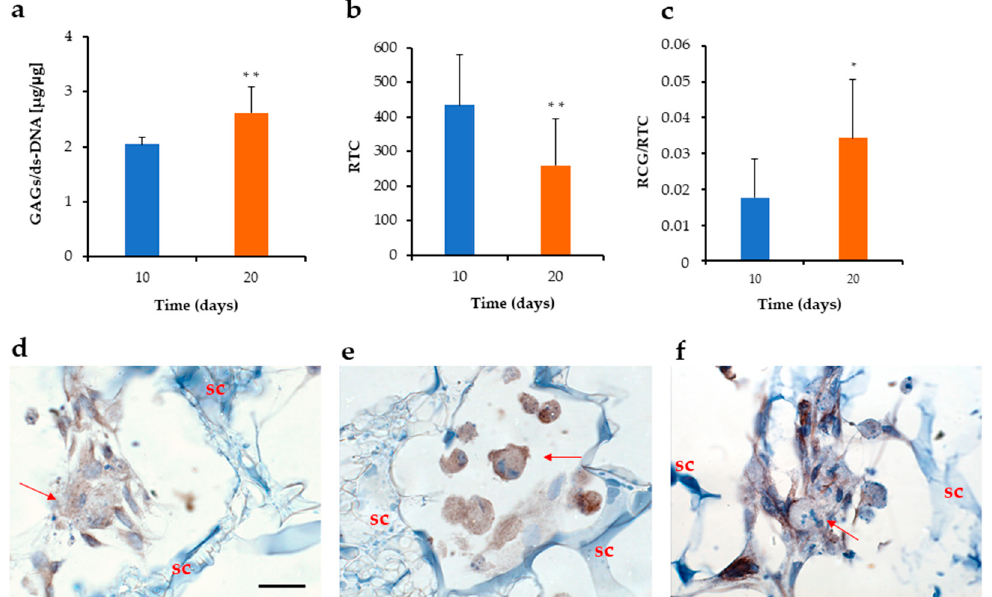
Figure 4. Bar graphs of the 3D cartilage model at 10 and 20 differentiation days: ( a ) GAG content normalized by ds-DNA content; ( b ) RTC number evaluated at 10 and 20 days; ( c ) RCG number normalized by RTC evaluated at 10 and 20 days. * p < 0.05; ** p < 0.01. RTC = Rounded Total Cells; RCG = Rounded Cell Groups. ( d – f ) Immunohistochemistry for Sox-9, Aggrecan and collagen type II in brown, showing cell groups. Arrows point to examples of viable cell nuclei. Scale bar = 20 µ m. Original magnification 1000 ×